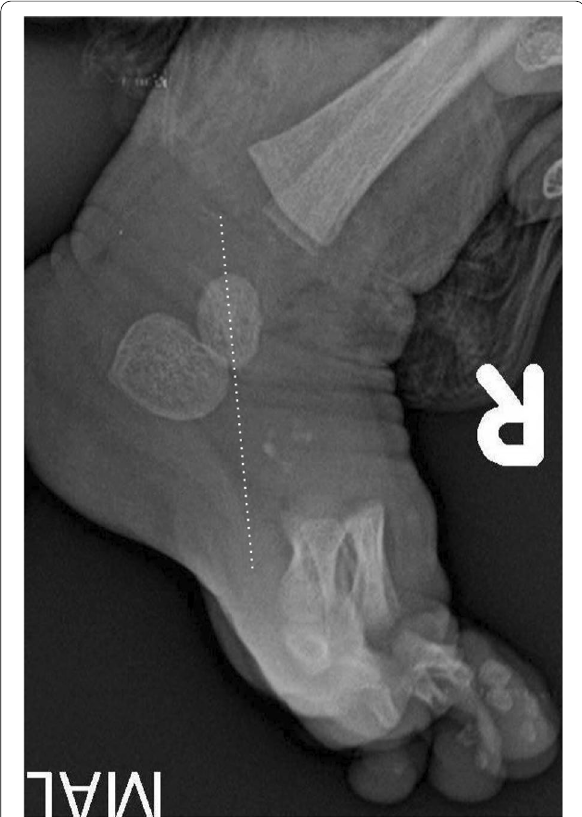
Fig. 9 Plain X-ray lateral view of 23-day-old male baby showing vertically oriented talus